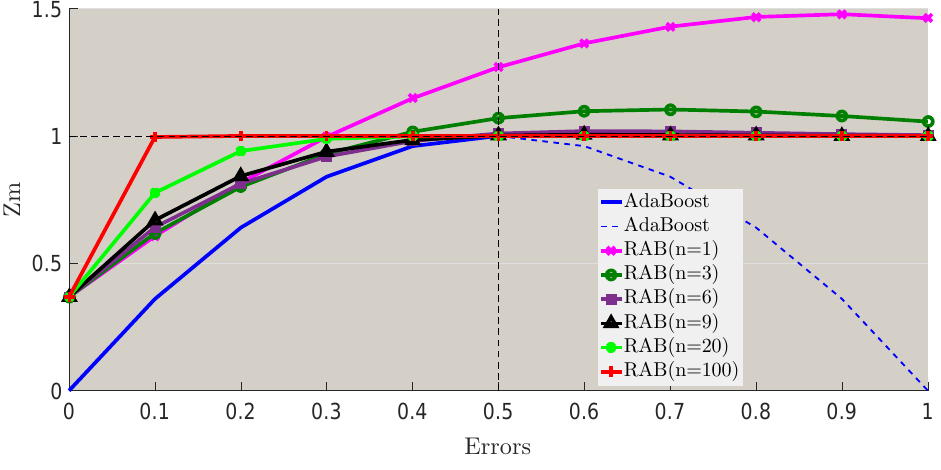
Figure 8. Weights normalization values of